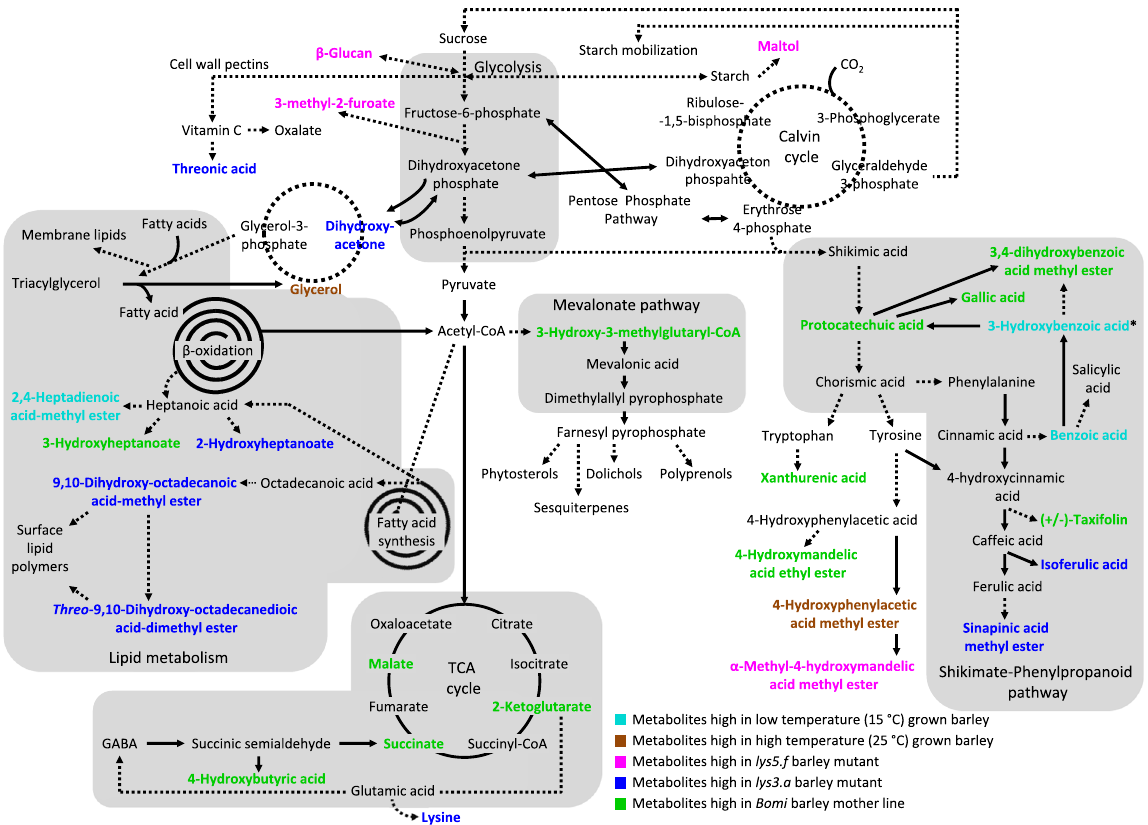
Figure 6. General overview of the major metabolic pathways in the barley plant and statistically significant metabolite markers for the growth temperature and genotype effects. Metabolite markers for the low (LT) and high (HT) temperature growth conditions are highlighted in cyan and brown, respectively. Metabolite markers for the genotype are highlighted in magenta, blue and green for lys5.f , lys3.a and Bomi, respectively. Solid arrows represent single enzymatic steps prior to metabolite biosynthesis, while dotted arrows show multi-enzymatic steps. P-values from the ANOVA test and fold changes in relative concentrations of markers are summarised in Supplementary Table